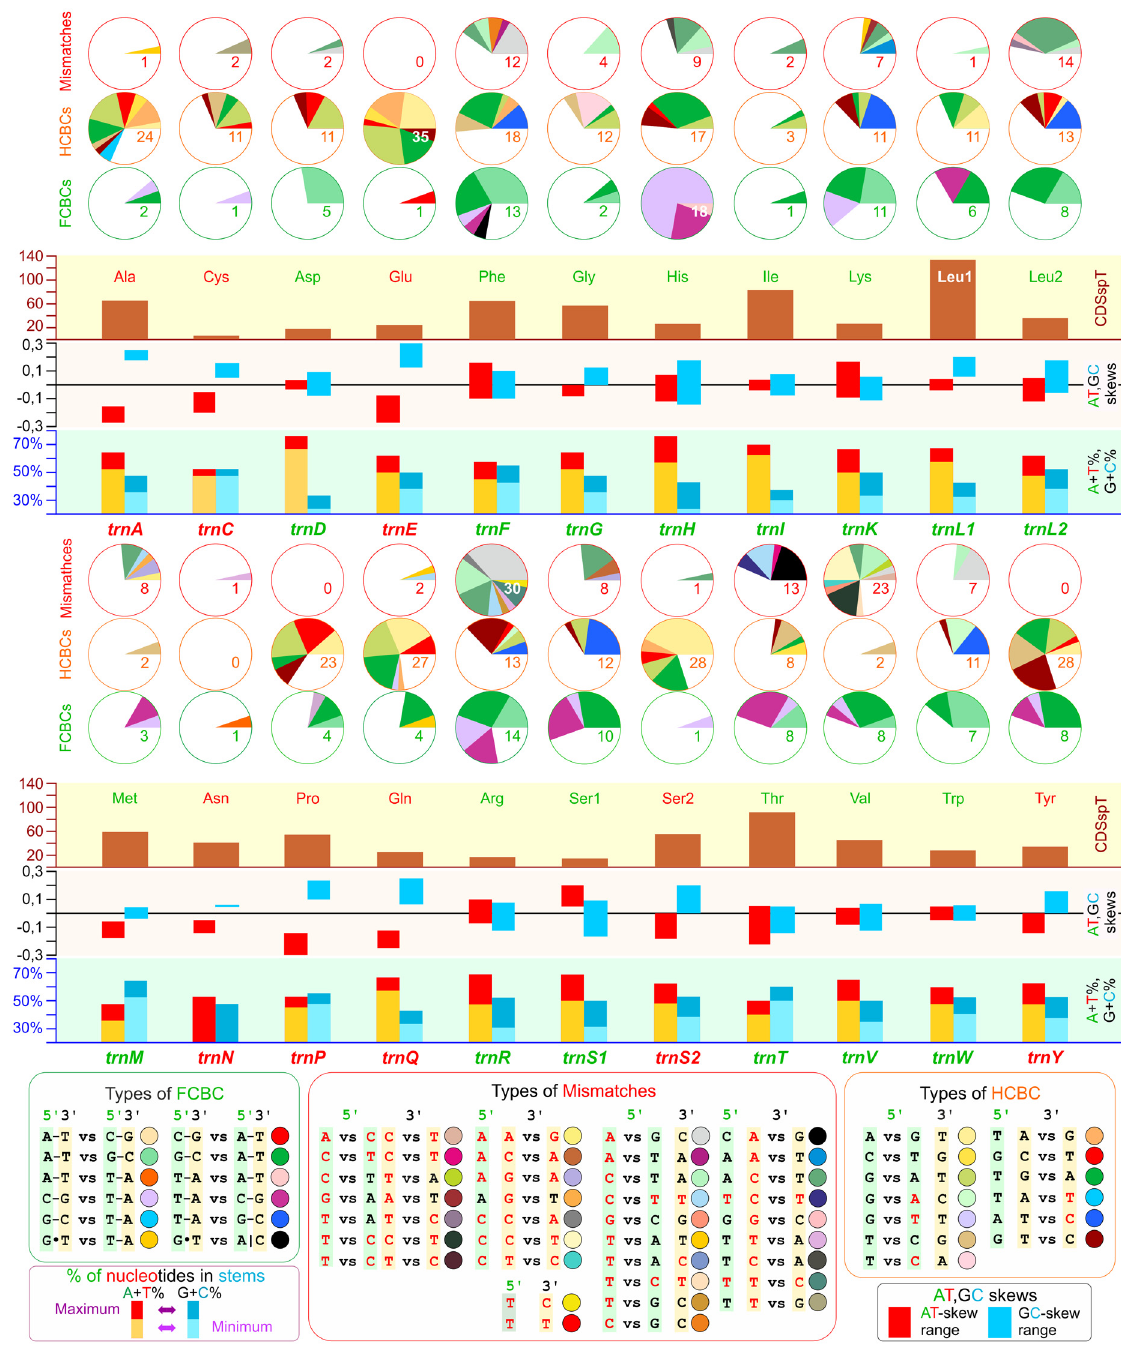
Fig 2. CSBPSs, skews, stems composition, and codon usage linked to the Cetacea tRNAs. CSBPS, change in sequence in a base pair of a stem; FCBC, fully compensatory base change; HCBC, hemi compensatory base change; Mismatch, mismatch in a base pair of a stem. The extension of the slices determining the number and type of FCBCs, HCBCs, and Mismatches for every tRNA was scaled, assuming that the whole coverage of a Pie graph was reached only in the tRNA exhibiting the maximum number of in CSBPSs. This approach allows, in our view, to better appreciate the variation of CSBPSs in the various tRNAs. CDSpT, codons per thousand codons associated to a tRNA. A+T%, percentage of A+T in the stems; G+C%, percentage of G+C in the stems. For A+T% and G+C%, the maximum and minimum values are provided. AT- and GC-skews, skews calculated for the stems of tRNAs. For AT- and GC-skews, the range of variation is provided for every